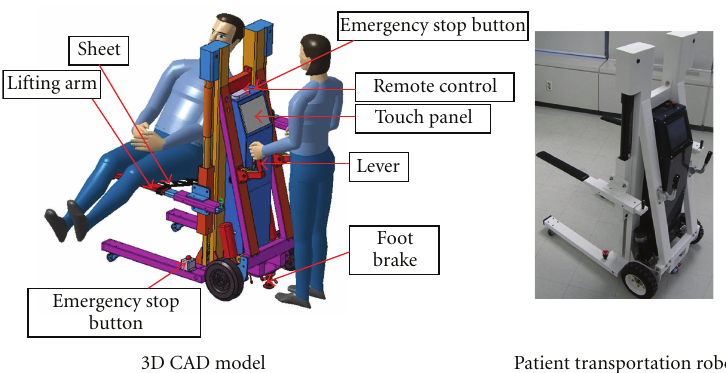
Figure 16: The patient transportation robot.